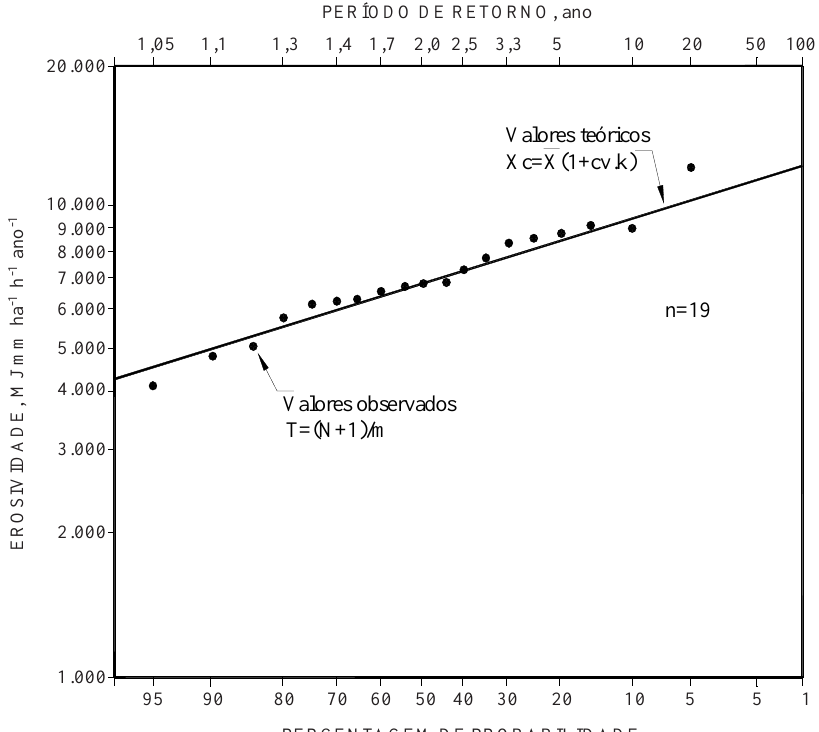
Figura 2. Distribuição da probabilidade de ocorrência e do período de retorno dos valores anuais de de Teodoro Sampaio (SP) no período de 1976 a 1994. erosividade EI 30